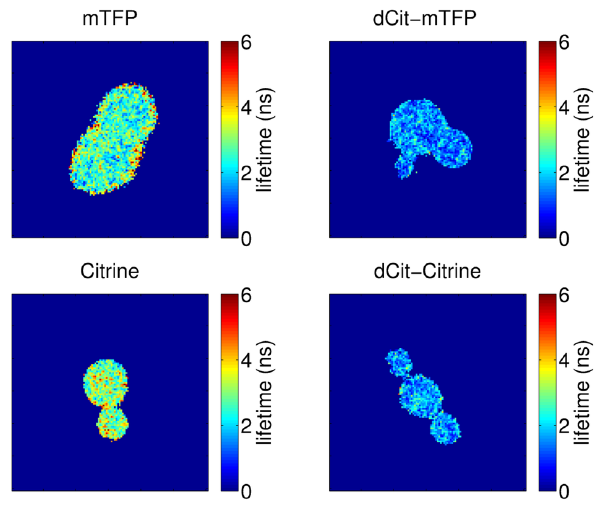
Figure 2. dCit-TFP and dCit-Citrine proteins have shorter lifetimes. False color fluorescence lifetime images of yeast cells expressing TFP (upper left), dCit-TFP (upper right), Citrine (lower left) and dCit-Citrine (lower right). Light from regions colored dark blue was below the threshold for lifetime computation.